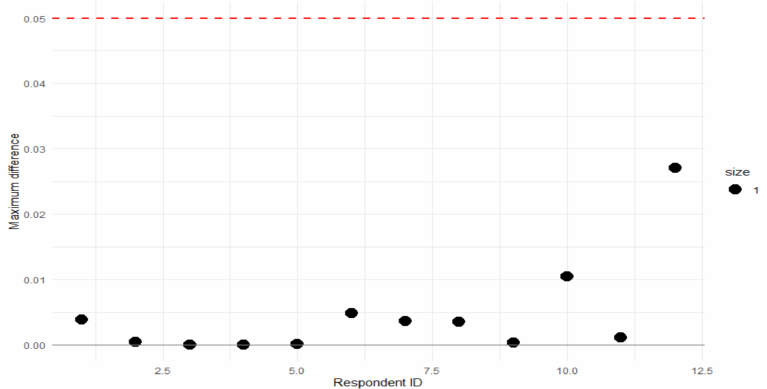
Figure 8. Maximum differences between eigenvalue and mean aggregation (use values).